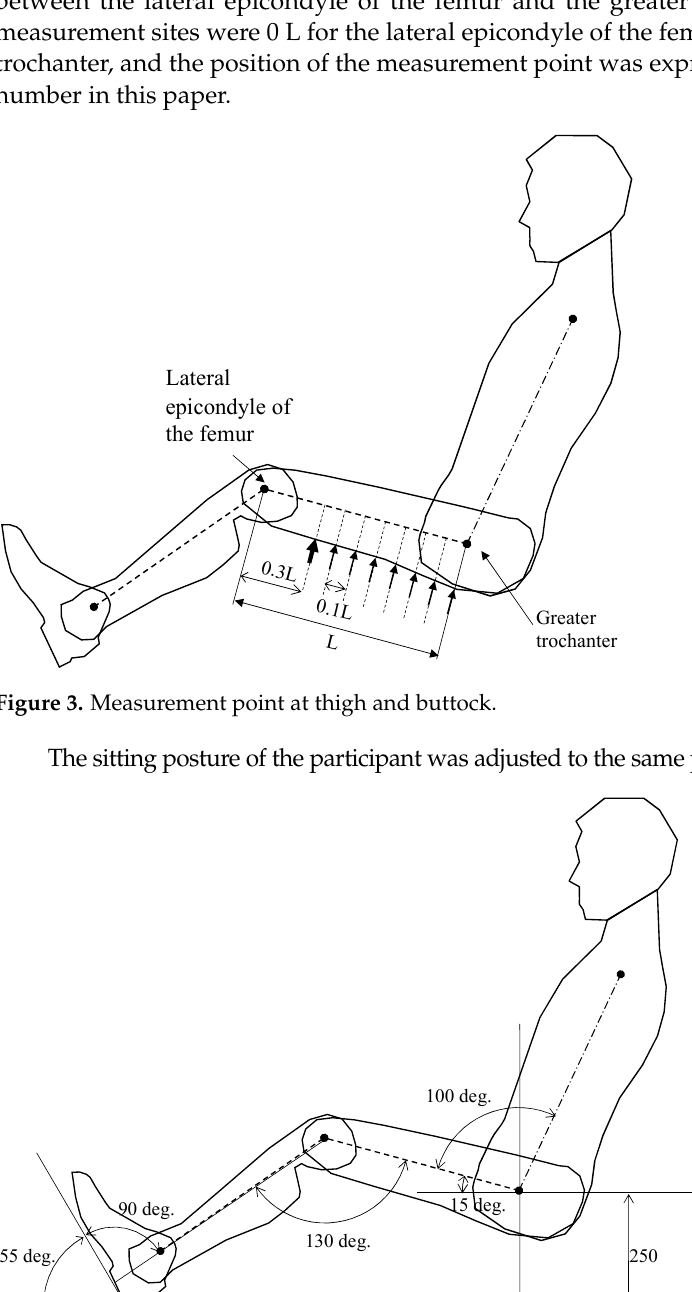
Figure 2. Sensitivity measurement seat.